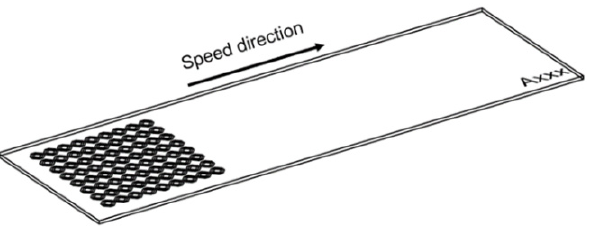
Figure 4. Draught image of octagonal donut shape for LST (design type A) texturing.